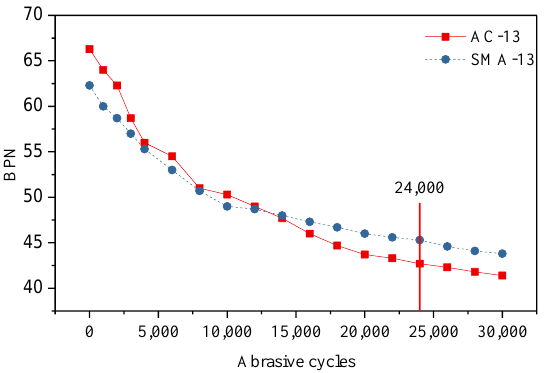
Figure 4. The BPN of AC-13 and SMA-13 with various abrasive cycles.